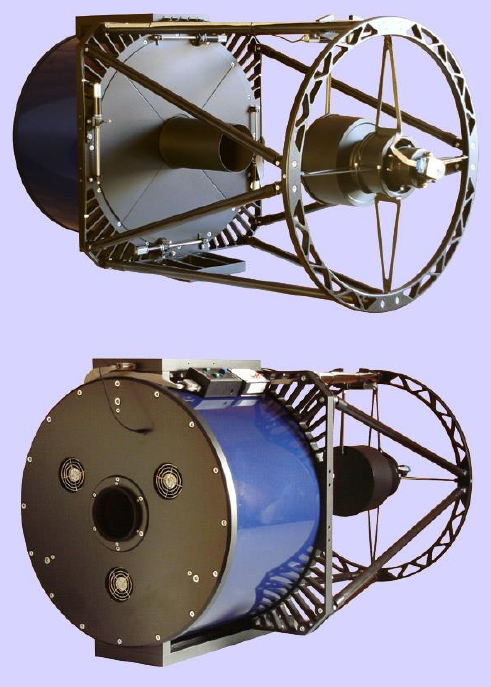
Figure 4. General view of the 0.5-m telescope of the